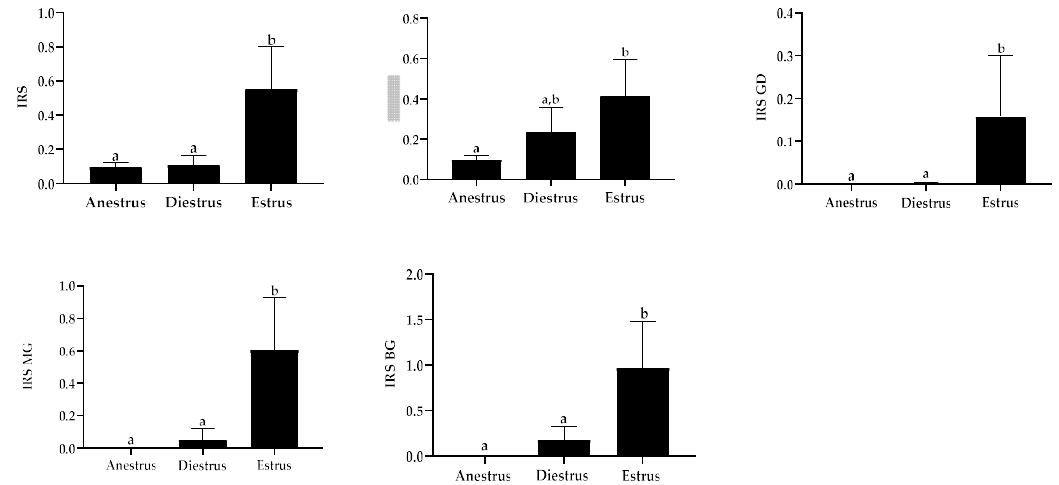
Figure 5. Myeloperoxidase immunoreactive score (IRS) among the studied phases in general and for each cell population. Data are displayed as raw data (mean with SD). Columns with a different superscript are statistically different ( p < 0.05). LE: luminal epithelium; GD: glandular ducts; MG: mid glands; BG: basal glands. In estrus, the maximal MPO expression was observed in basal glands. This was not observed in diestrus where IRS values between basal glands and luminal epithelium were not statistically different (Figure 6). MPO expression in endometrial tissues did not corre- late with either R T or R A in the uterine fluid for the different studied cell populations and groups. Figure 6. Myeloperoxidase immunoreactive score (IRS) in estrus and diestrus for each cell popula- tion. Data are displayed as raw data (mean with SD). Columns with a different superscript are sta- tistically different ( p < 0.05). LE: luminal epithelium; GD: glandular ducts; MG: mid glands; BG: basal glands. 4. Discussion Myeloperoxidase is mainly contained and released by neutrophils and hence consid- ered as a marker of inflammation in different organs and tissues [5]. Presence of MPO in uterine lavage fluids at variable concentrations has been demonstrated in mares during estrus regardless of the presence of neutrophils [24]. This is concordant with the results of